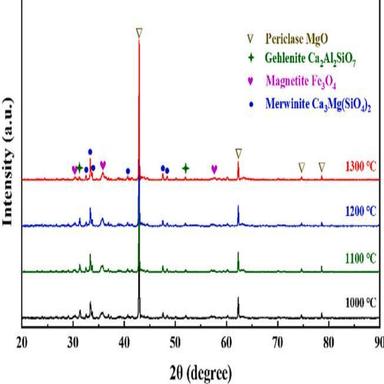
XRD patterns of samples with different sintering temperatures.